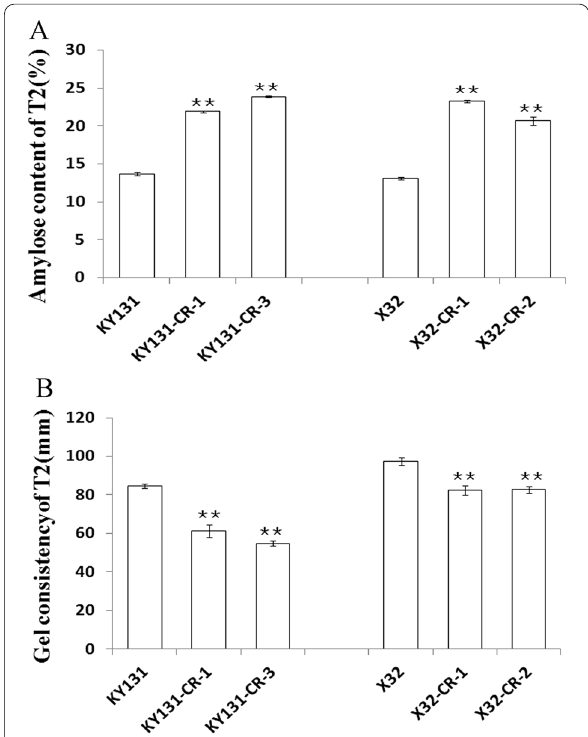
Fig. 3 Amylose content and gel consistency of endosperm in wild-type and 2nd-generation mutant plants (T2). A Amylose content of endosperm in wild-type and 2nd-generation mutant plants (T2). B Gel consistency of endosperm in wild-type and 2nd-generation mutant plants (T2). Data are presented as the mean a significant difference at P < 0.01 (t